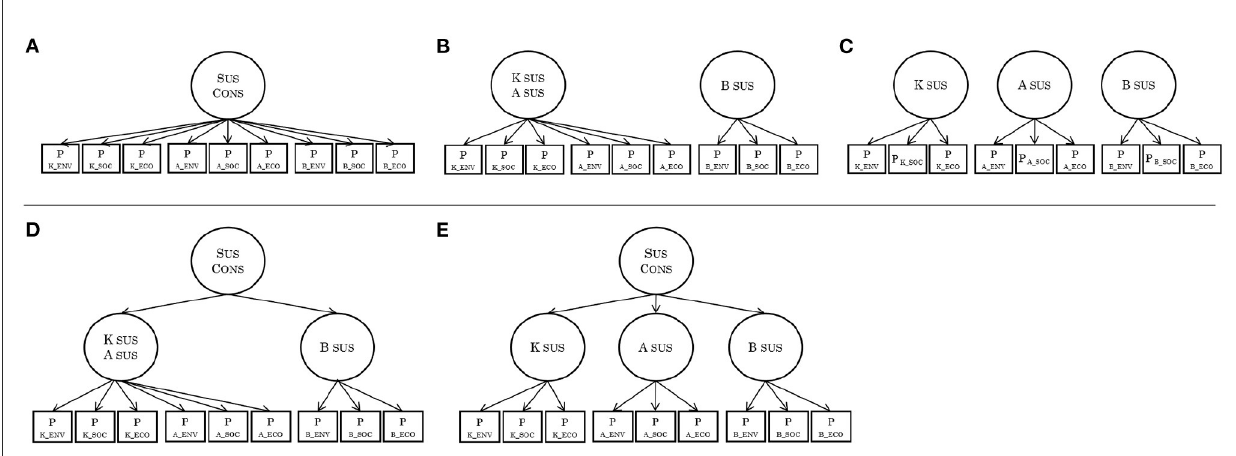
FIGURE4 Overview of factor structures. (A) One-factor model; (B) Two-factor model; (C) Three-factor model; (D) Two-factor hierarchical model; (E) Three-factor hierarchical model. P for each factor item indicates that the corresponding data were parceled. K, knowingness; A, attitudes; B, behavior; ECO, economic; SOC, social; ENV, environmental; Sus Cons, sustainability consciousness.